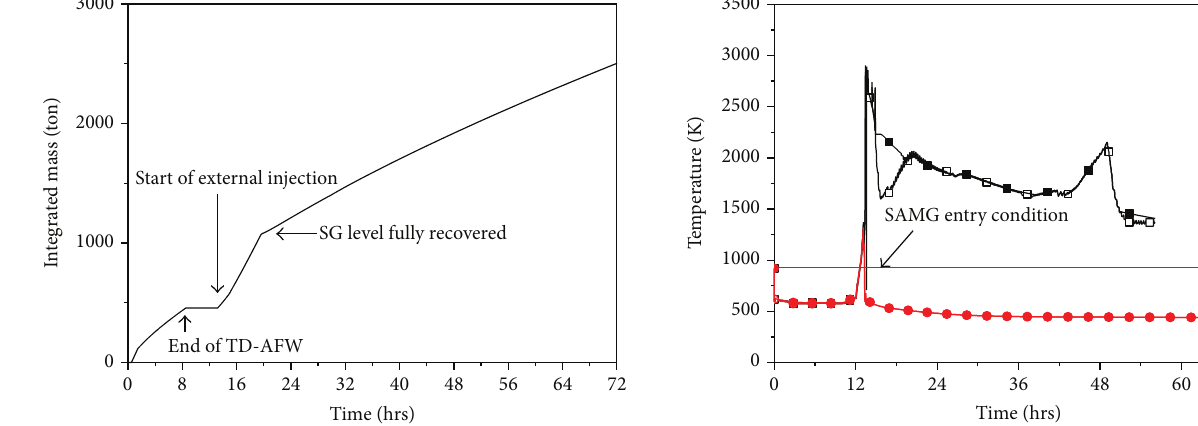
Figure 11: Integrated mass inventory of secondary injection.